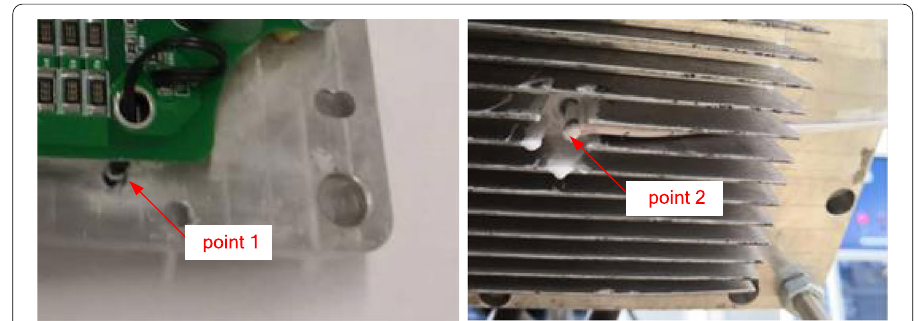
Fig. 6 Mounting positions of the temperature measurements